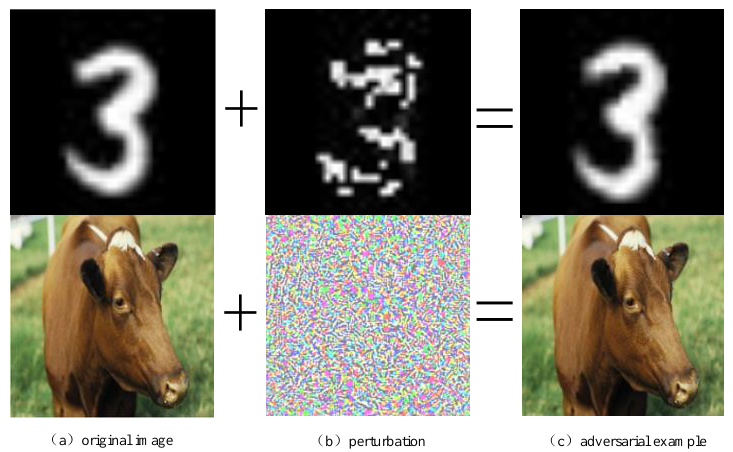
Figure 1. Adversarial example generation process, by adding ( b ) perturbation to ( a ) original samples, ( c ) adversarial examples can be obtained.